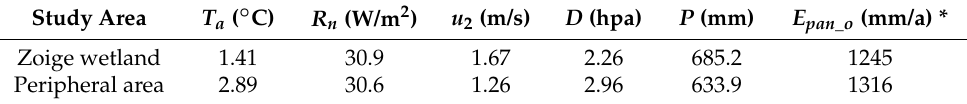
Table 2. Statistical values of the annual average temperature ( T a ), net radiation ( R n ), wind speed ( u 2 ), vapor pressure deficit ( D ), precipitation ( P ) and pan evaporation ( E pan_o ) in the Zoige wetland and its peripheral areas between 1969 and